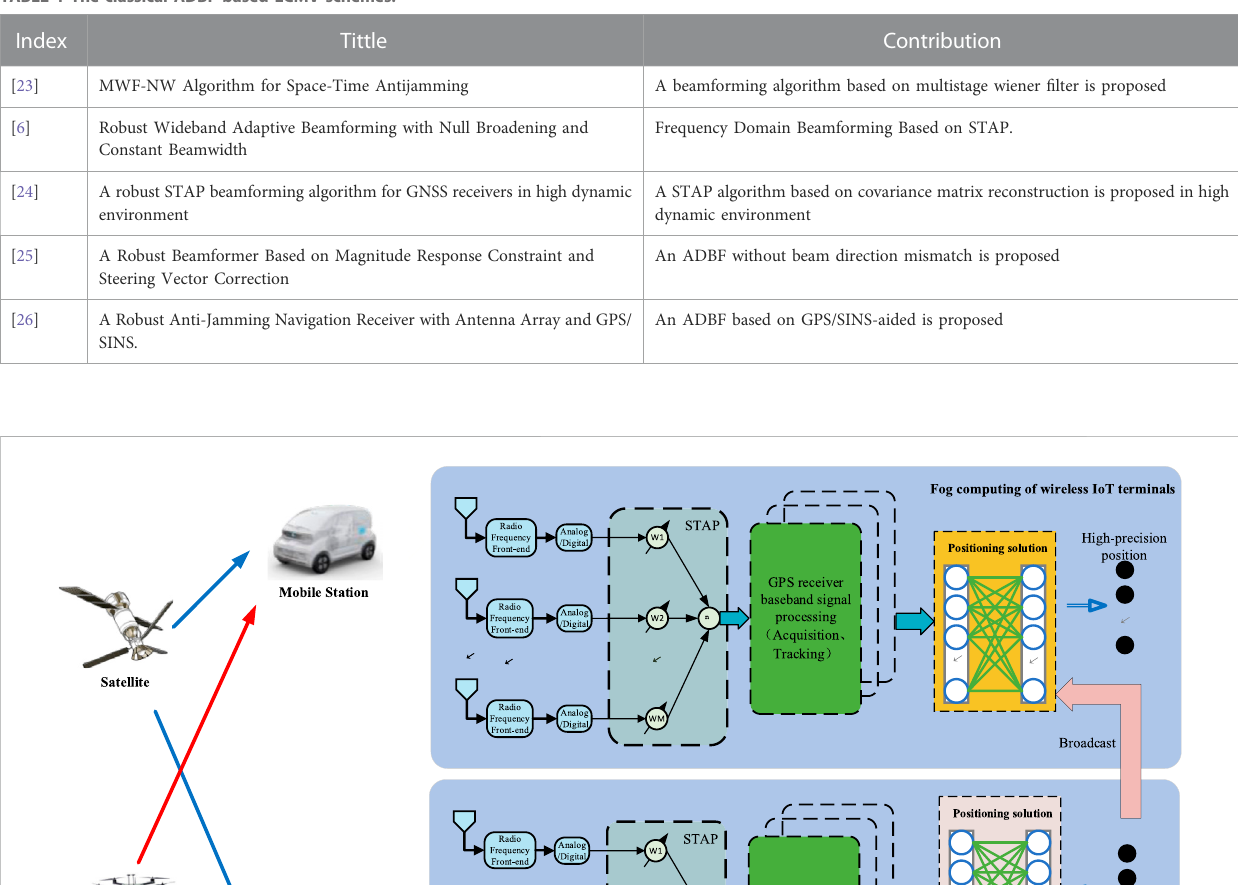
TABLE 1 The classical ADBF based LCMV schemes.